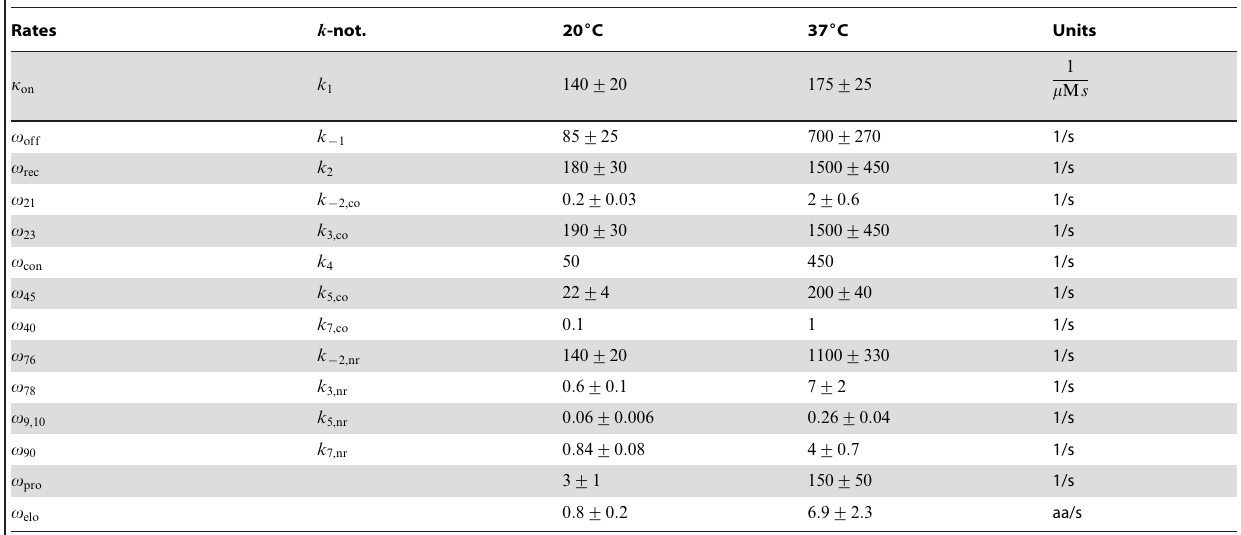
Apart from the processing rate v pro , all individual rates and the overall elongation rate v elo have been measured in vitro at 20 u C and/or 37 u C. The processing rate v pro was calculated from the overall elongation rate v elo via Eq. 22 in the Methods section. The column ‘k-not.’ provides the notation for the transition rates as used in Ref. [6]. (Supporting Figure S1). As explained in the Methods section (Eq.